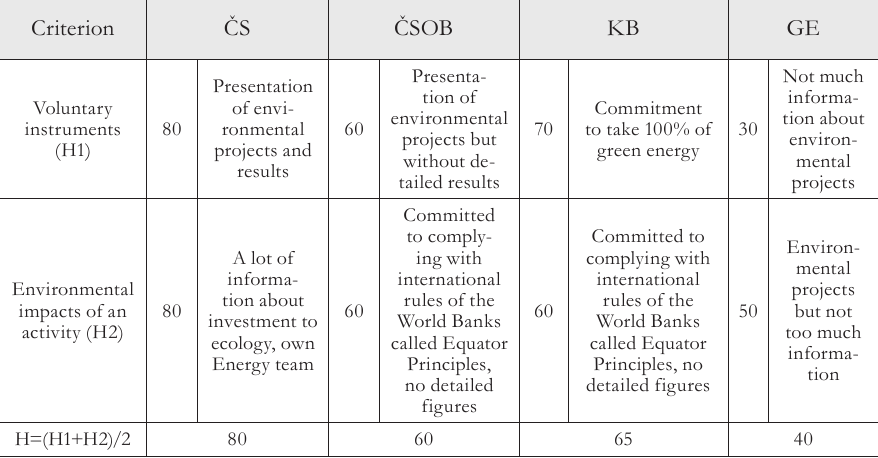
Tab. 8 - Evaluation criteria in the area of the Environmental policy. Source: